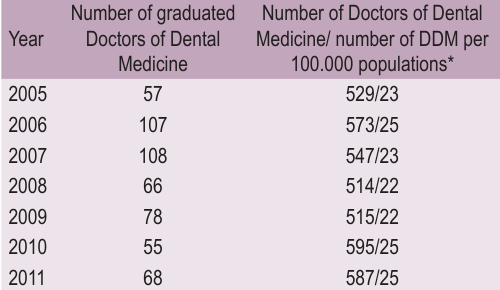
TABLE 1. The number of graduated doctors of dental medi- cine during the period from 2005 to 2011 and number of doc- tors of dental medicine/ number of DDM per 100.000 popula- tions employed in public sector during the same time